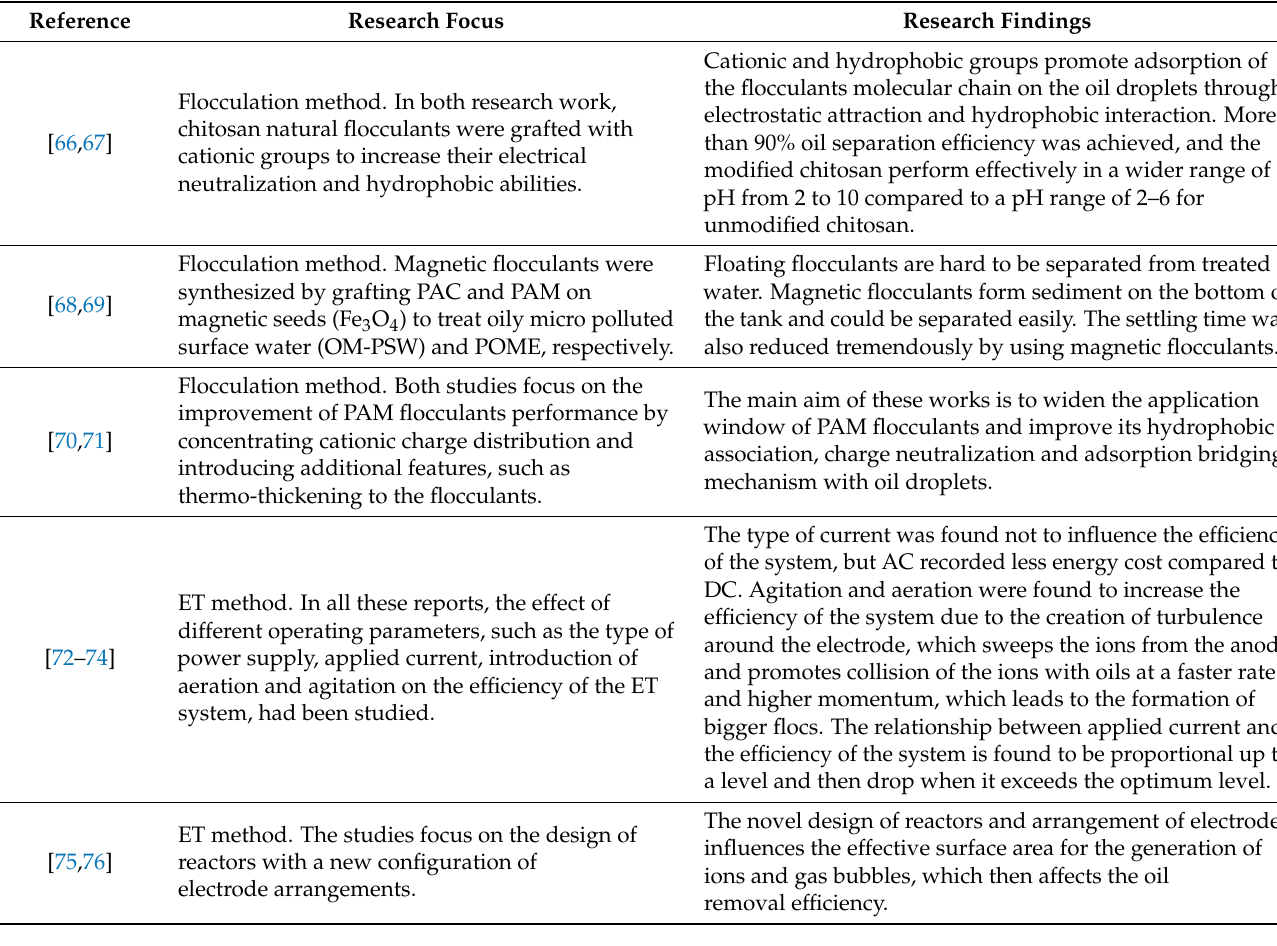
Reference Research